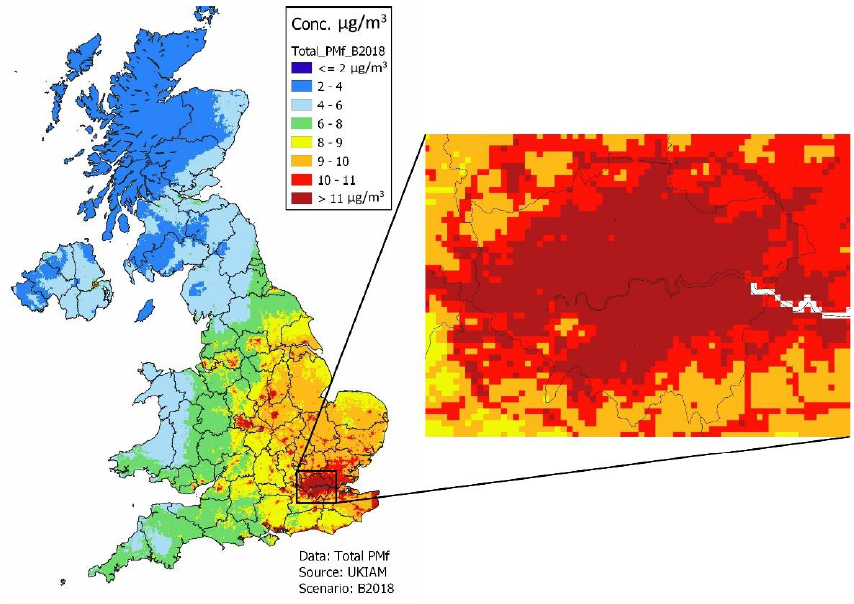
Figure 3. Total modelled PM 2.5 concentrations (1 × 1 km resolution) show a gradient from SE to NW, with London showing widespread high concentrations in 2018.